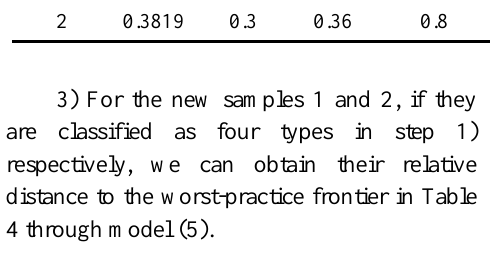
Table 4. The new sample’s relative distance to the worst-practice frontier